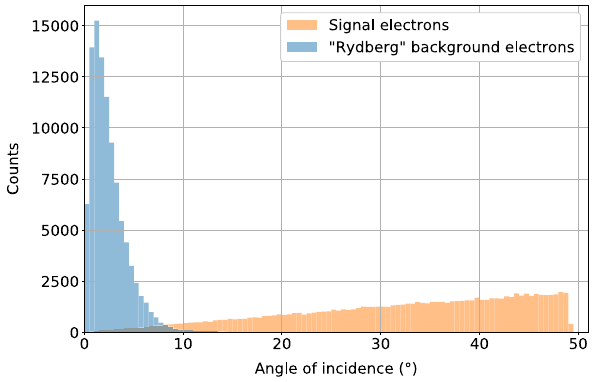
Fig. 1 Angular distributions of signal (orange) and “Rydberg” back- groundelectrons(blue)atthedetectoroftheKATRINexperimentsimu- latedfor10 5 electronsusinginputfrom[6].Thesimulationconsidersthe energy spectrum of background electrons which are ionized by black- body radiation at room temperature from hydrogen (36%) and oxygen atoms (64%) in highly excited Rydberg states. These Rydberg atoms are sputtered from the spectrometer walls due to α -decays of implanted 210 Pb progenies from the 222 Rn decay chain [5]. The Rydberg atom’s energies from [6] are corrected for the surface binding energy and – after ionisation – the electron energy and direction are calculated with the Doppler shift of the Rydberg atoms taken into